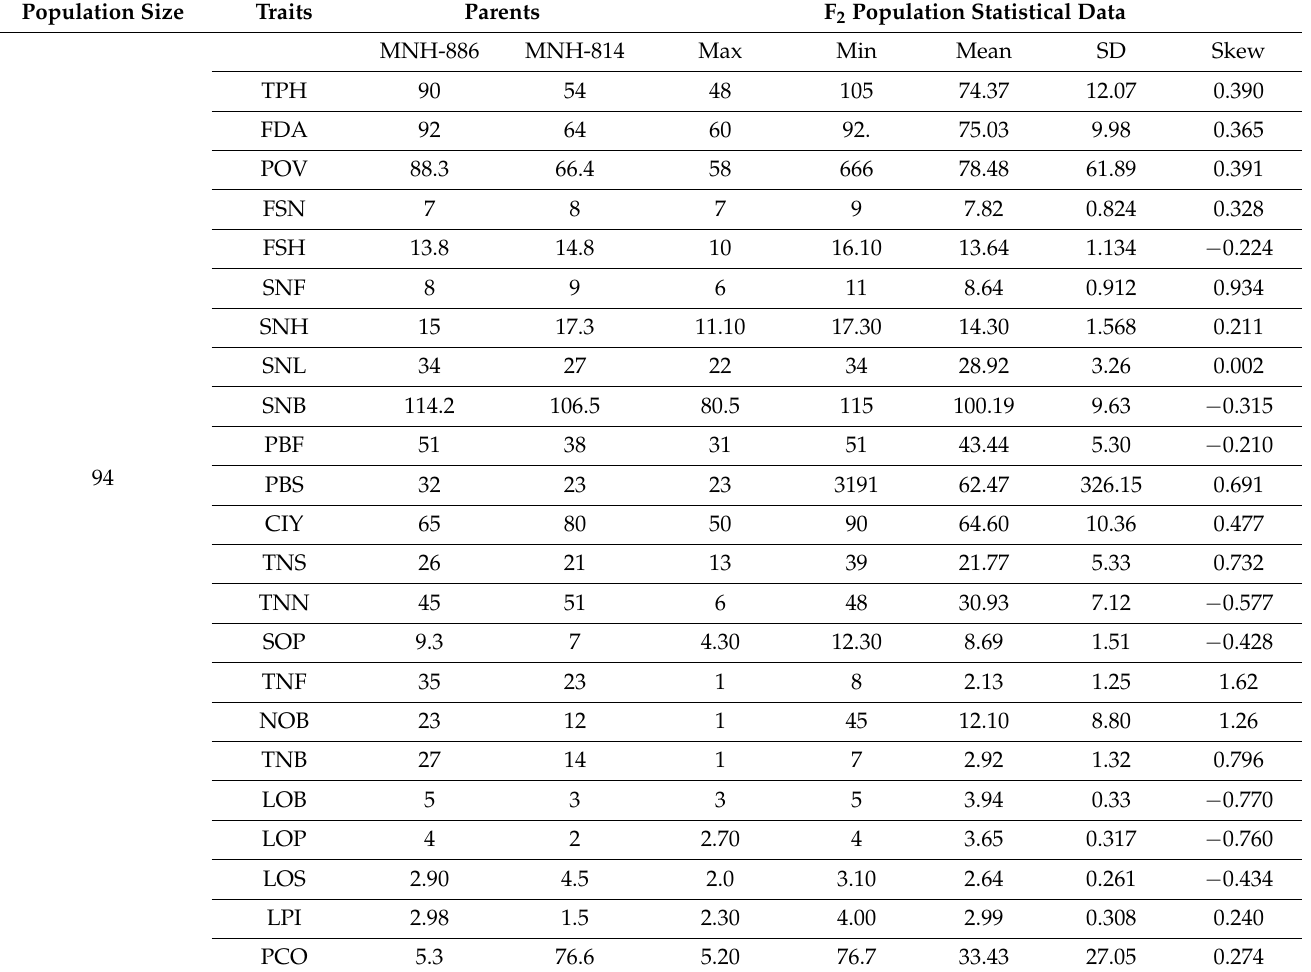
Table 3. Phenotypic values for heat tolerance traits of F 2 population and their